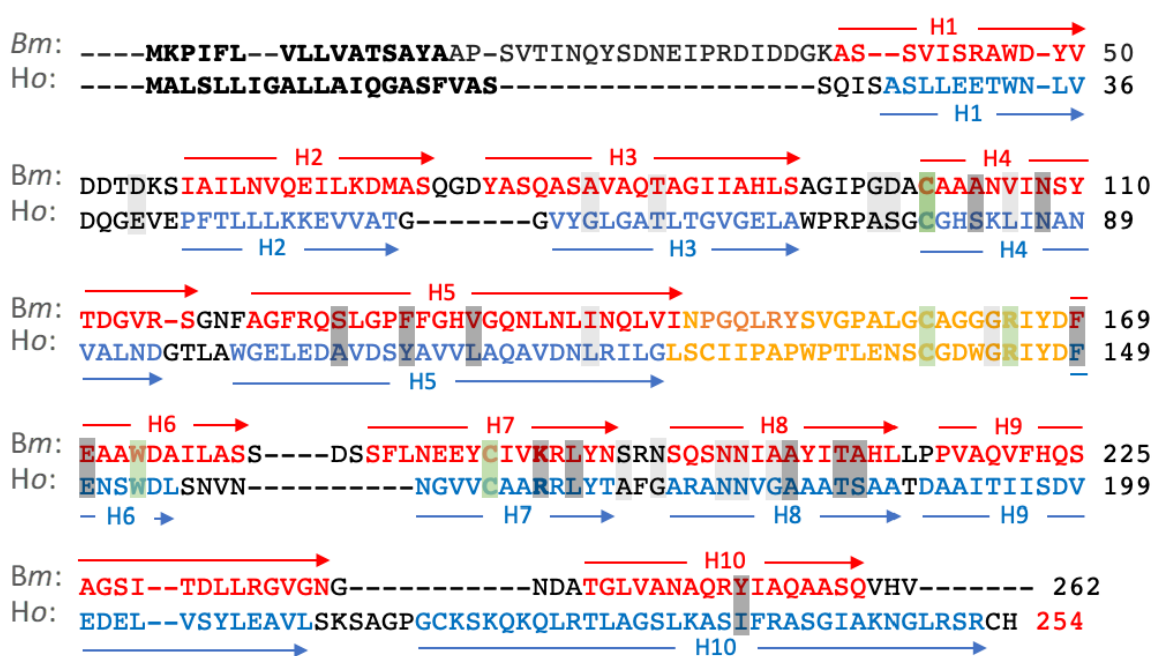
Figure 1. Alignment of B. mori ( Bm ) and H . occidentalis ( Ho ) L-fib sequences extracted from the full sequence alignment (Figure S1). This is not a pairwise alignment of Bm and Ho . Secretion signal peptides are bold and are included in the numbering. Positions of helices are indicated by colored text and arrows. The unstructured region connecting helix 5 and 6 is indicated by yellow text. Invariant amino acids are shaded green. Strongly conserved amino acids and less strongly conserved amino acids are shaded dark gray and light gray, respectively.